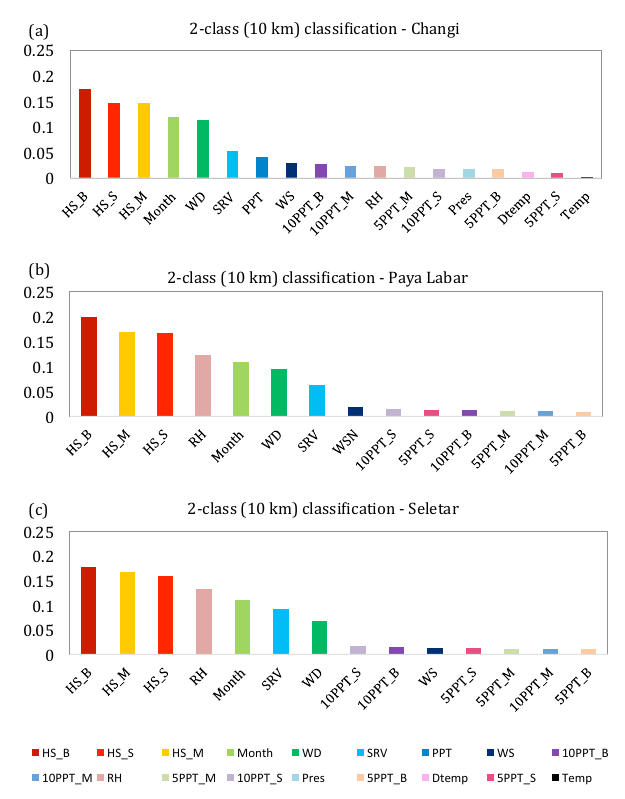
Figure 8. Feature importance by using two-class classification ran- dom forest algorithm in (a) Changi, (b) Paya Lebar, and (c) Seletar. Desired outputs, haze versus non-haze events, are defined by us- ing visibility 10km as a breakpoint. The full names of each input feature are listed in Table